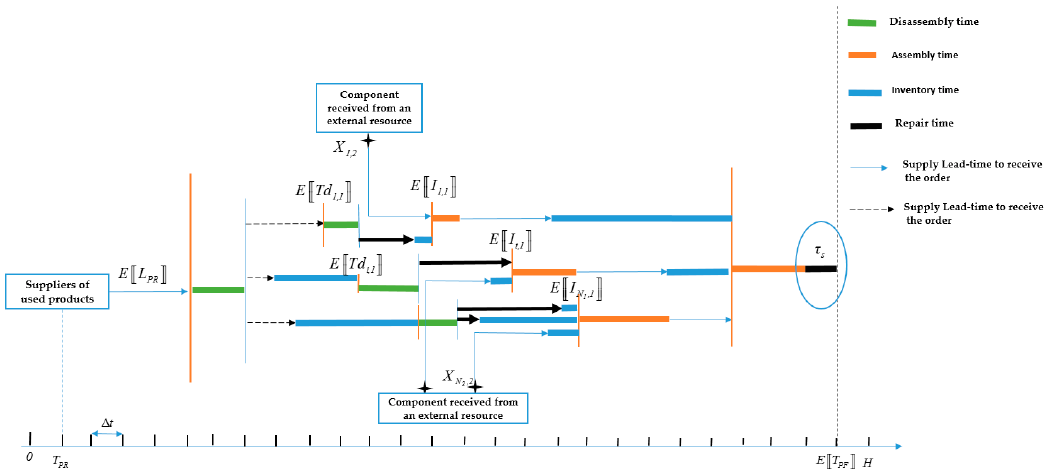
Figure 11. Threshold period for repairing corrective maintenance actions.